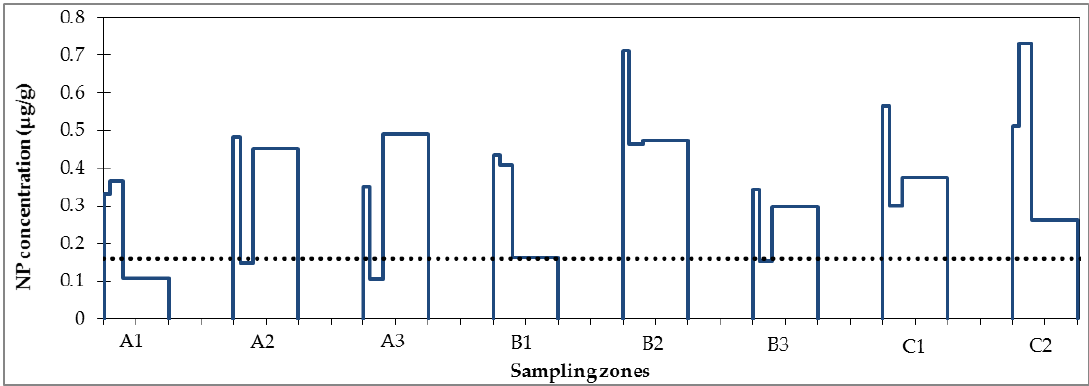
scale from left to right. The dotted line represents the concentration measured in the initial soil